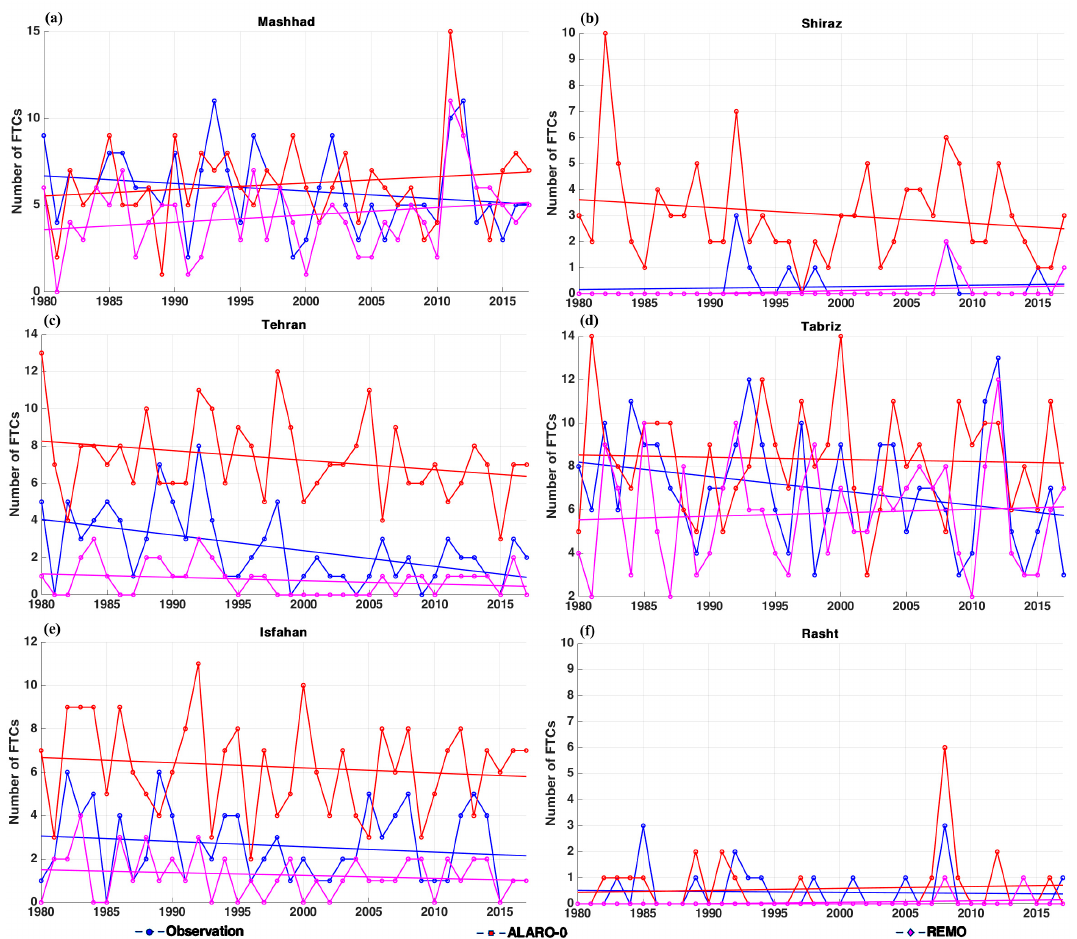
Table 3. Model performance for FTC index over six studied stations (1980–2017).